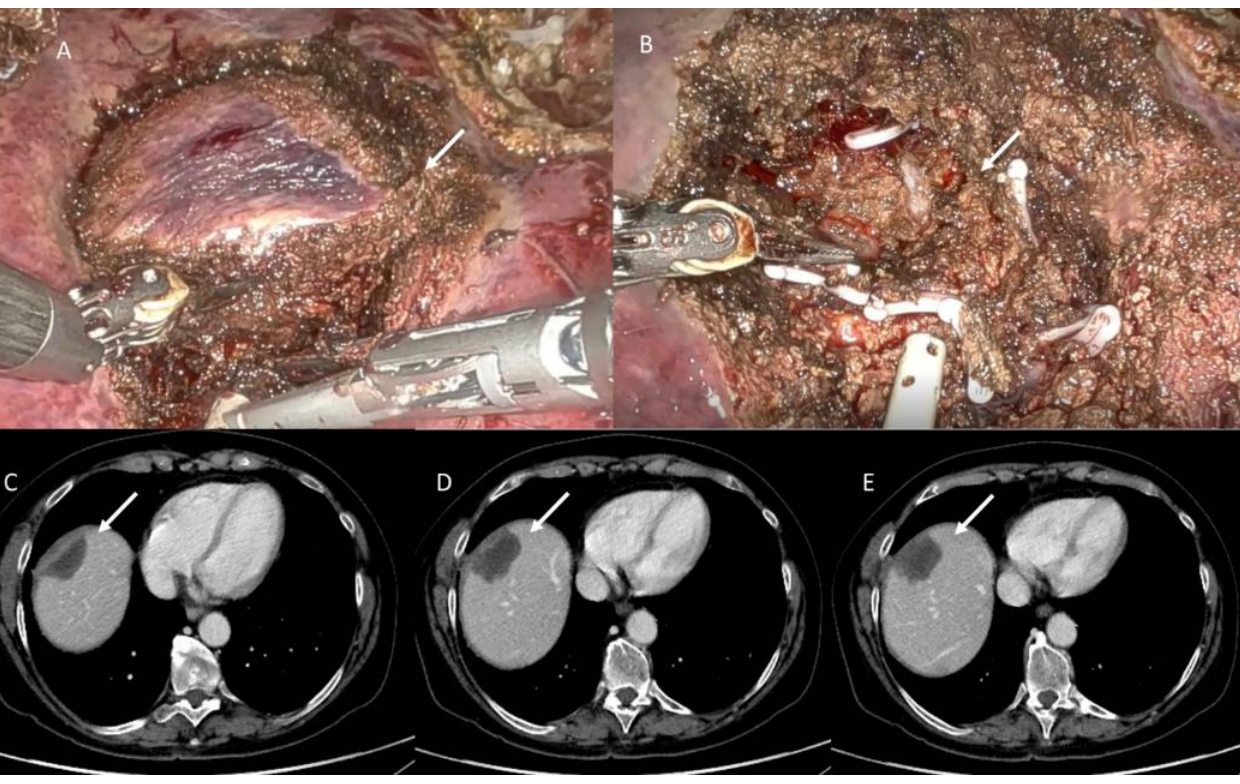
Figure 9. Robotic Anatomycal S2 segmentectomy in patient with HCC ( A ). In ( B , C ), CT assessment at 3 months follow-up: arrows show scar tissue. This tissue should be correctly distinguished from new lesions, expressions of disease recurrence [140,194 – 203]. On US assessment, scar tissue is iso-hyperecoic without contrast